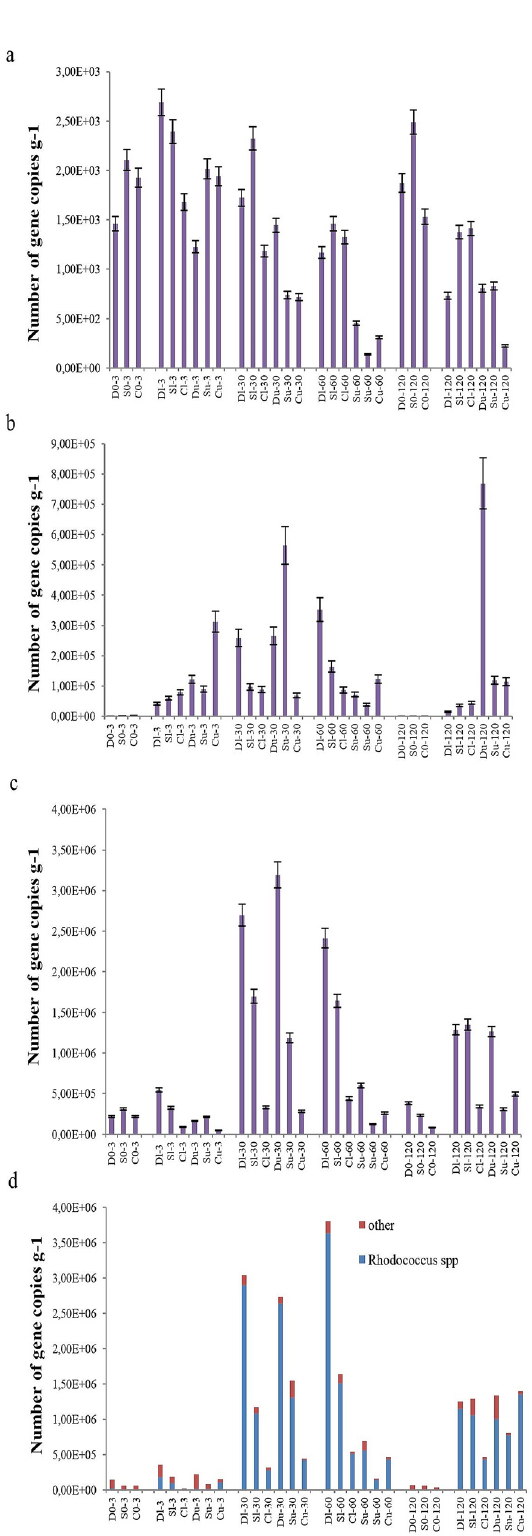
Figure 5. Gene copy numbers belonging to the alkI (a), alkII (b), and alkIII (c) groups and bacteria potentially carrying alkIII group genes ( Pseudomonas aeruginosa [alkB1] , Ps. fluorescens, Rhodococcus spp. [alkB1] , Burkholderia spp. [alkB] , Amycolatopsi s spp. [alkB]